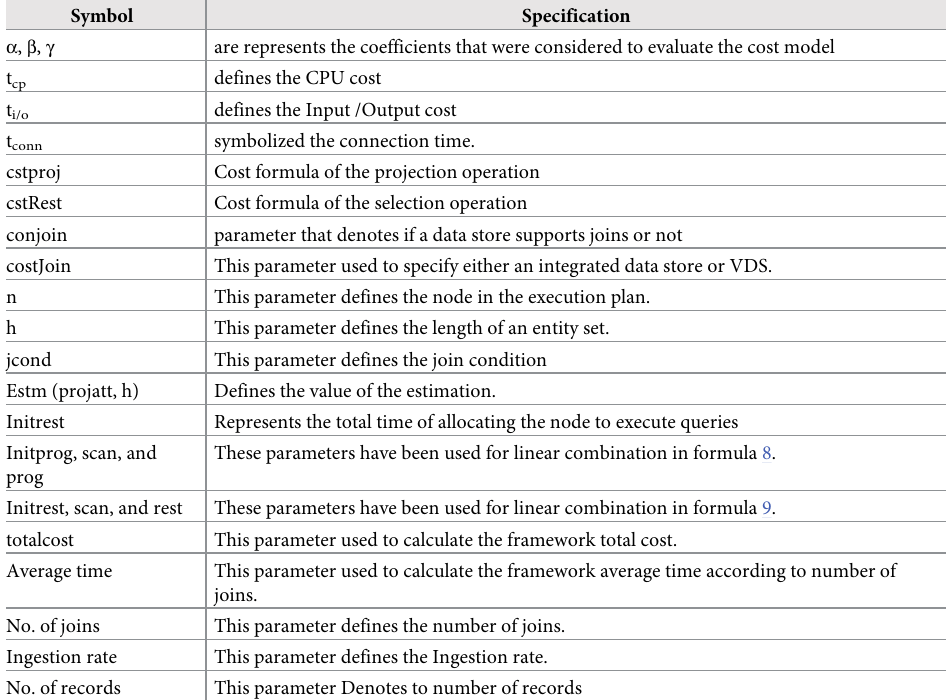
Table 3. Specification of the cost model parameters. Symbol